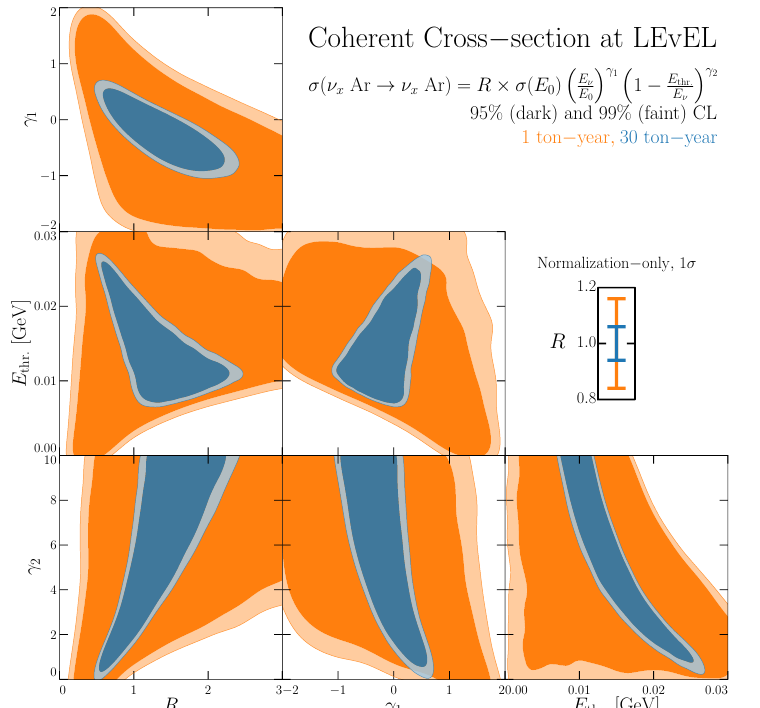
Figure 14. Similar to figure 8, the measurement capability of LEvEL according to the parame- terization of eq. (4.4), now with a zero-background assumption. The detector is assumed to be a distance of 18 m from the LHC Beam Dump instead of 15 m, resulting in a smaller signal rate. Systematic uncertainties ( 5% overall flux uncertainty and 10% kaon-to-pion production ratio un- certainty) are still included and marginalized